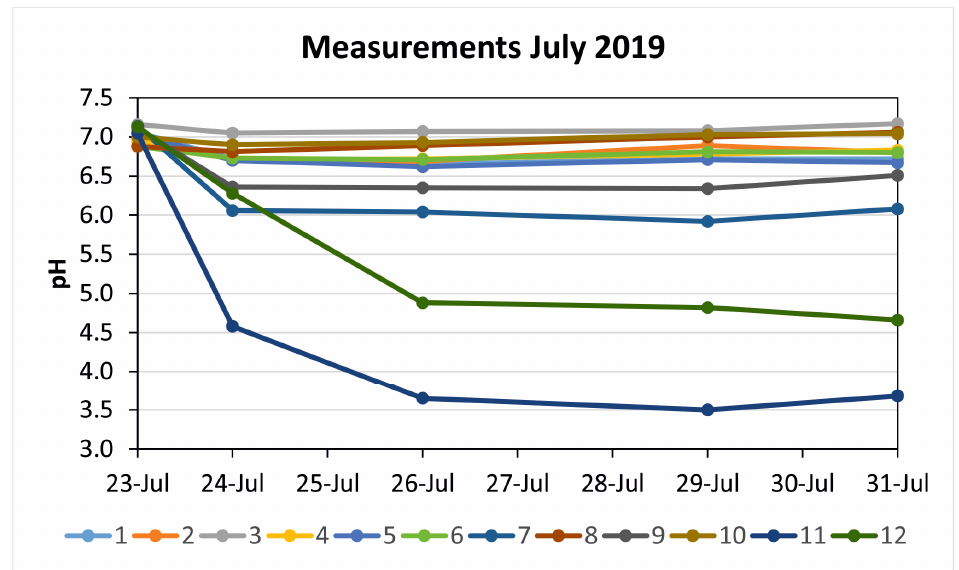
Figure 6. pH average results obtained during the evaluation carried out in July 2019. Numbers at the bottom of the X axis are the sensor numbers. Table 2. Sensor positions during the evaluation carried out in July 2019.